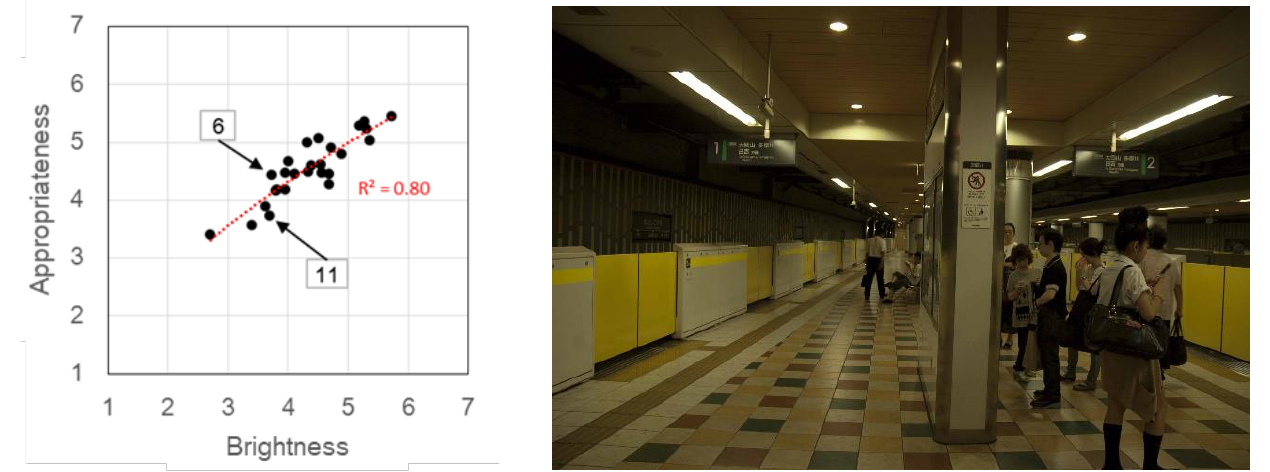
Figure 12. Correlation between brightness and appropriate lighting ( left ) and the front view of No. 6 ( right ).